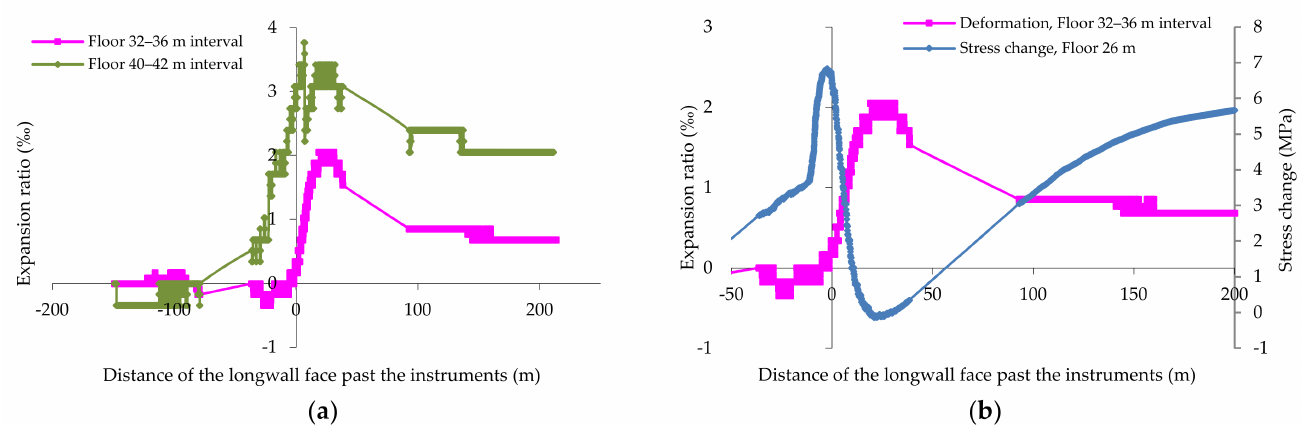
Figure 8. ( a ) The dynamics of strata expansion as LW 5121(5) advanced. ( b ) The correlation between the strata expansion ratio and stress change in the floor